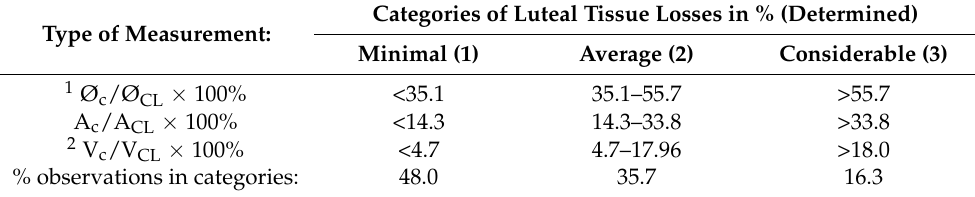
Table 7. Ranges of morphometric parameters of luteal tissue in the cavitary CL (according to the curve of distribution from Figure 4, n = 98).